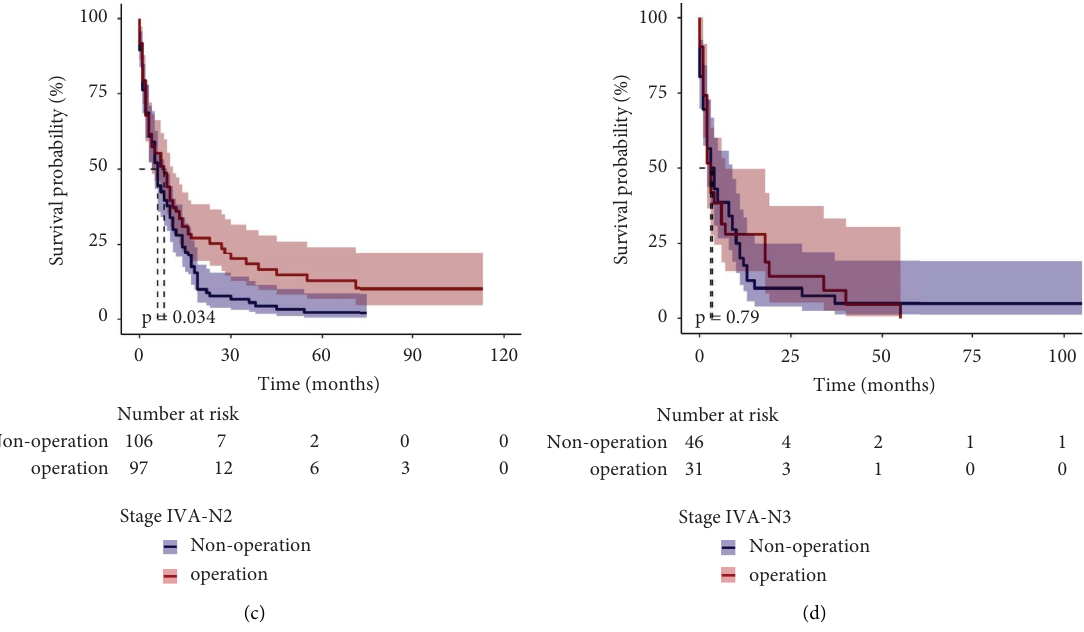
Figure 4: Kaplan − Meier plots for overall survival. (a) Stage IVA-N0; (b) stage IVA-N1; (c) stage IVA-N2; (d) stage